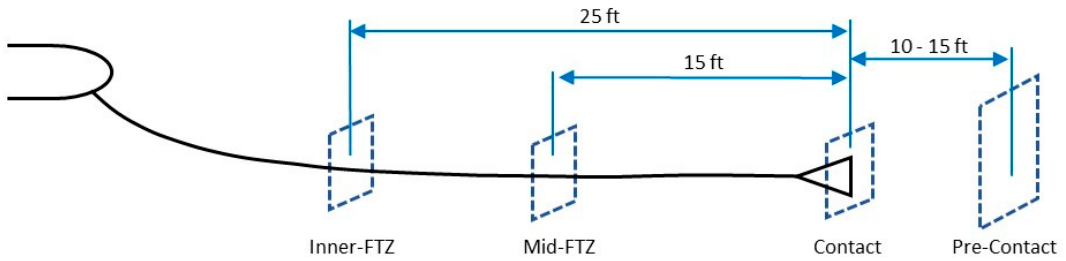
Figure 5. Fuel transfer zone example [18].